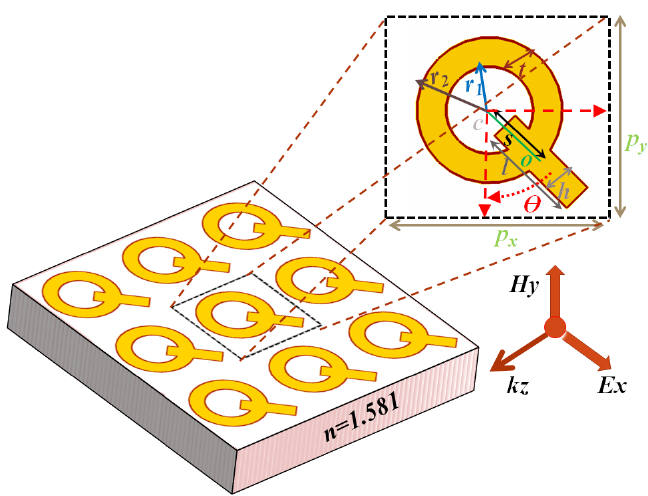
Figure 1. Schematic of the ring/rod gold metasurface.